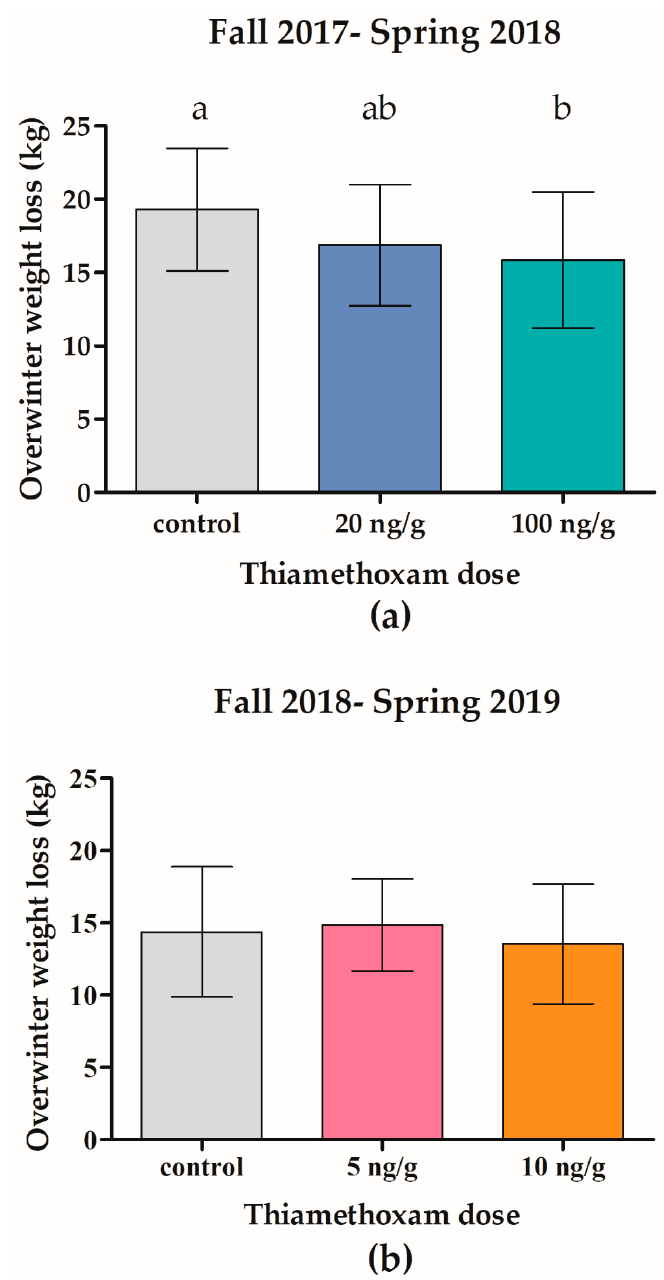
Figure 5. Colonies exposed to chronic high-dose (100 ng/g) thiamethoxam lost significantly less weight during winter compared to controls. Honey bee colonies were exposed to thiamethoxam (THI) during winter 2017–2018 in field trial 1 ( a ) or winter 2018–2019 in field trial 2 ( b ). Bars indicate mean ± SD overwinter (October to May) weight change in kg for twenty to twenty-two colonies. Different letters indicate significant differences, p < 0.05 by ANOVA.